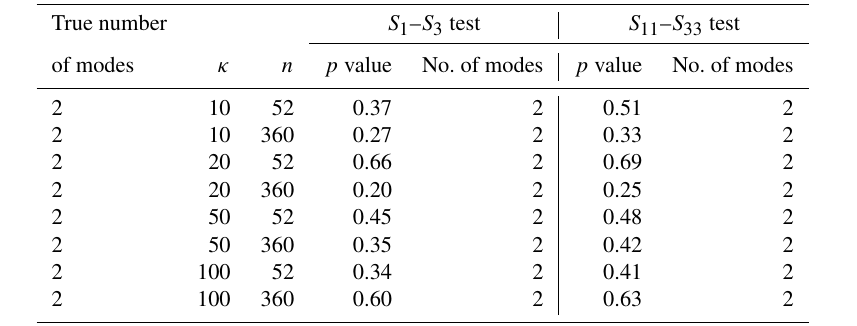
Table 1. The p values and corresponding decisions at the 5% significance level of randomisation tests of bimodality for bimodal equal mixtures of synthetic Watson distributions; n is the total sample size and B = 999 further randomisation samples per dataset (see text for details).